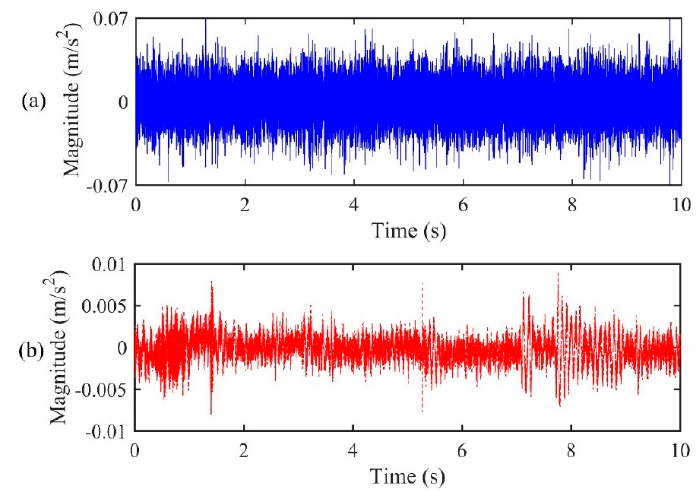
Figure 12. Leak signals measured by the accelerometer pair of ( a ) A2; ( b ) A3.